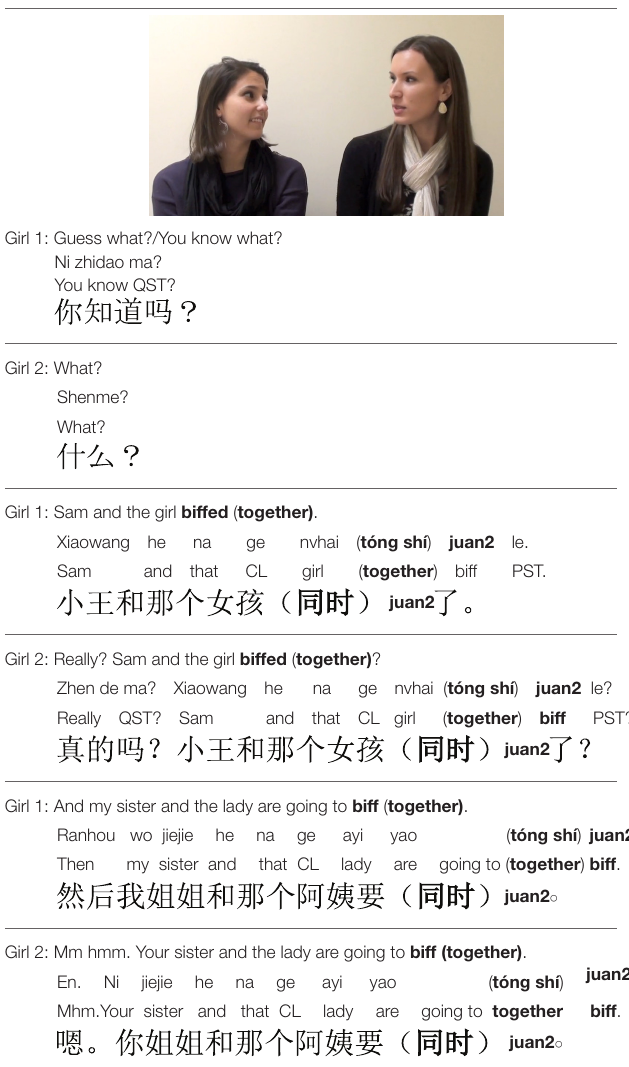
TABLE 1 | Familiarization Phase viewed by English participants in Experiments 1a, 1b (“VP Modifier” condition) and Mandarin participants in Experiments 2a,